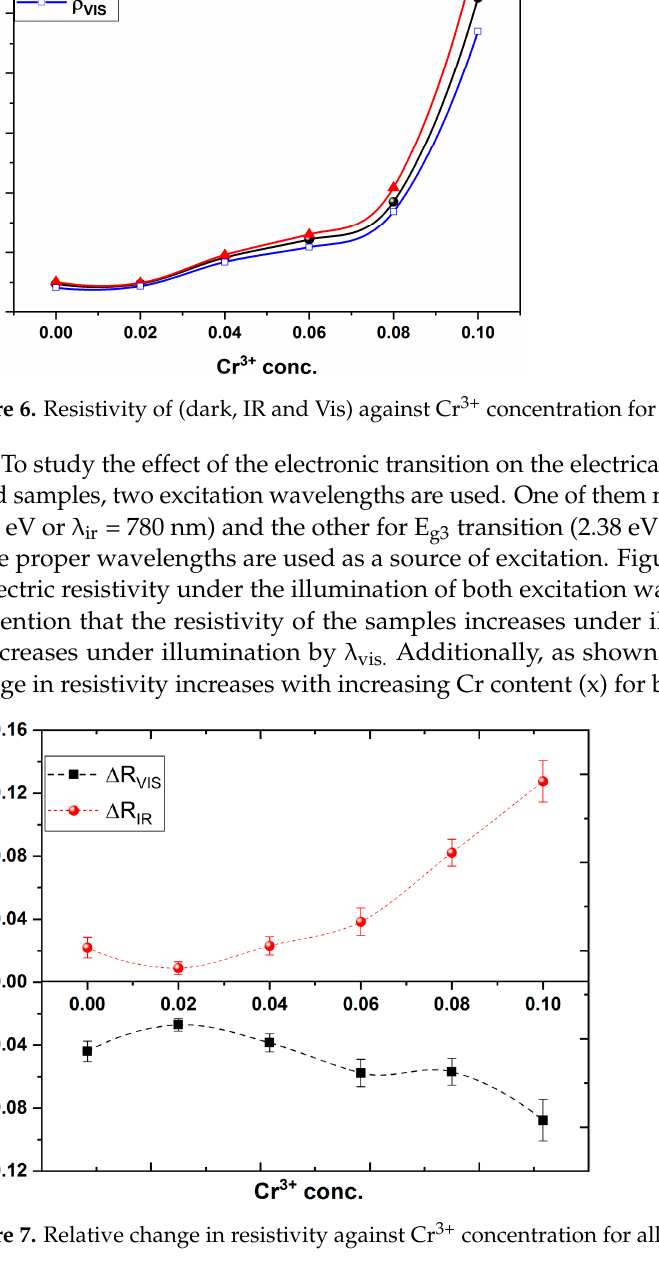
Figure 7. Relative change in resistivity against Cr 3+ concentration for all investigated thin films.